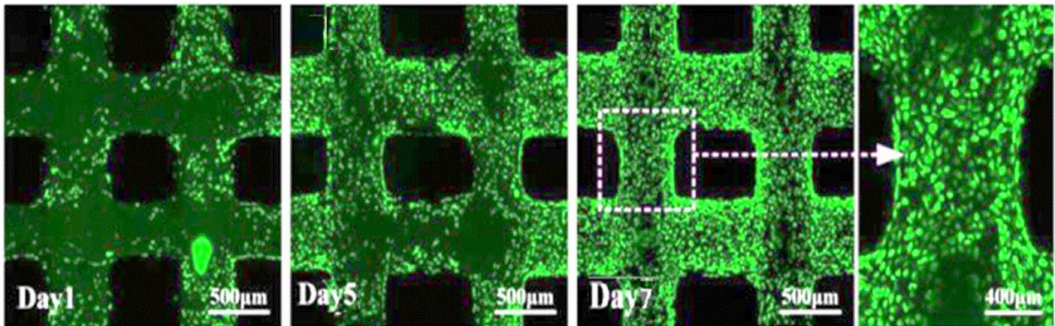
Figure 18. Cell viability and distribution in the sca ff old designs (green for living cells, red for dead cells).